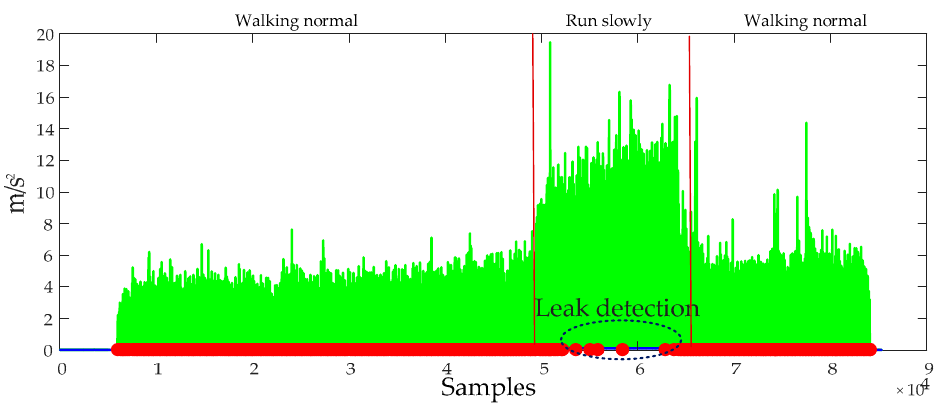
Figure 13. The result of the still-phase detection using δ ZUPT,1 with only 406 steps detected. The green lines denote the standard deviation of acceleration and the red dots denote the detected steps.